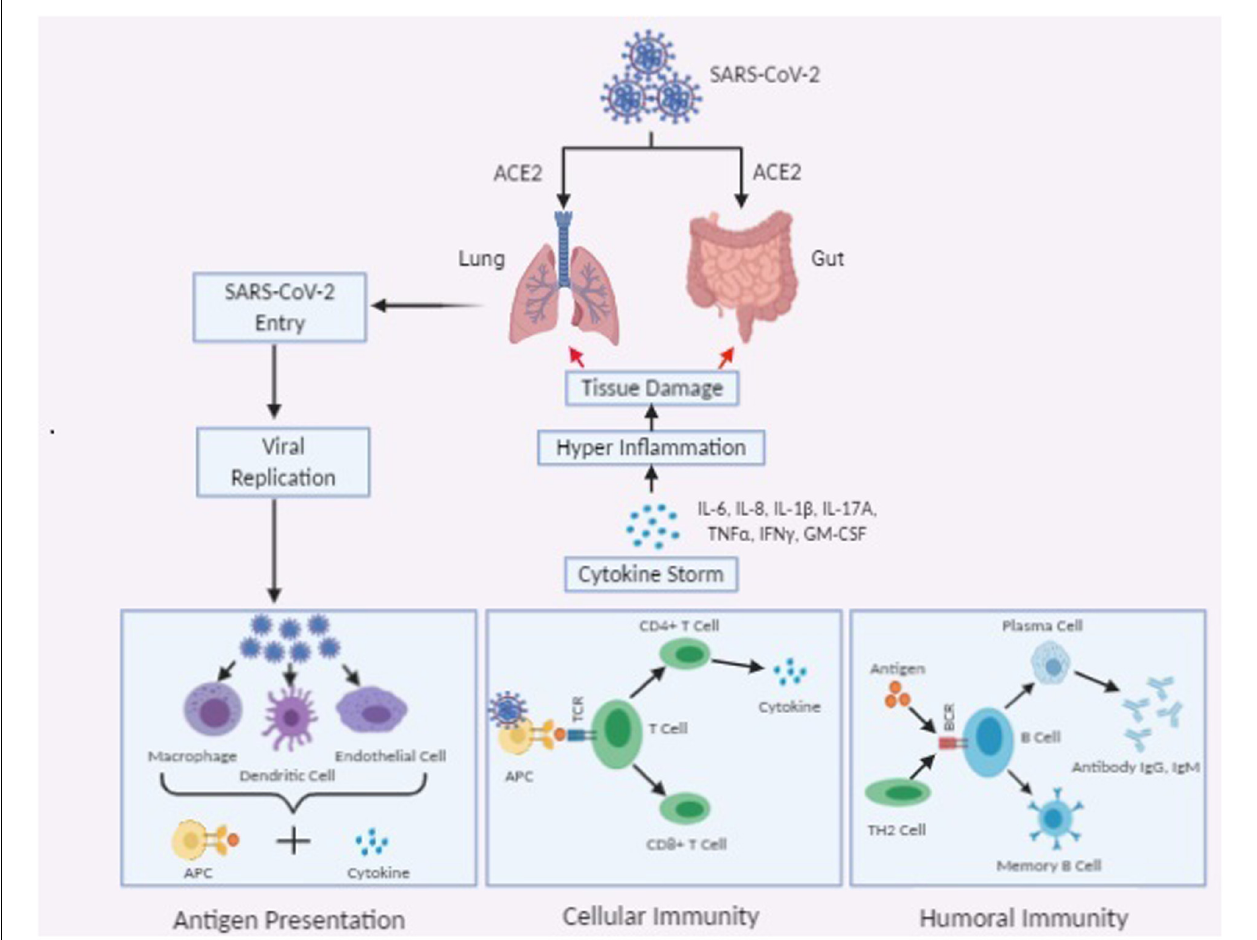
FIGURE 1 | Schematic representation of immunopathogenesis of SARS-CoV-2